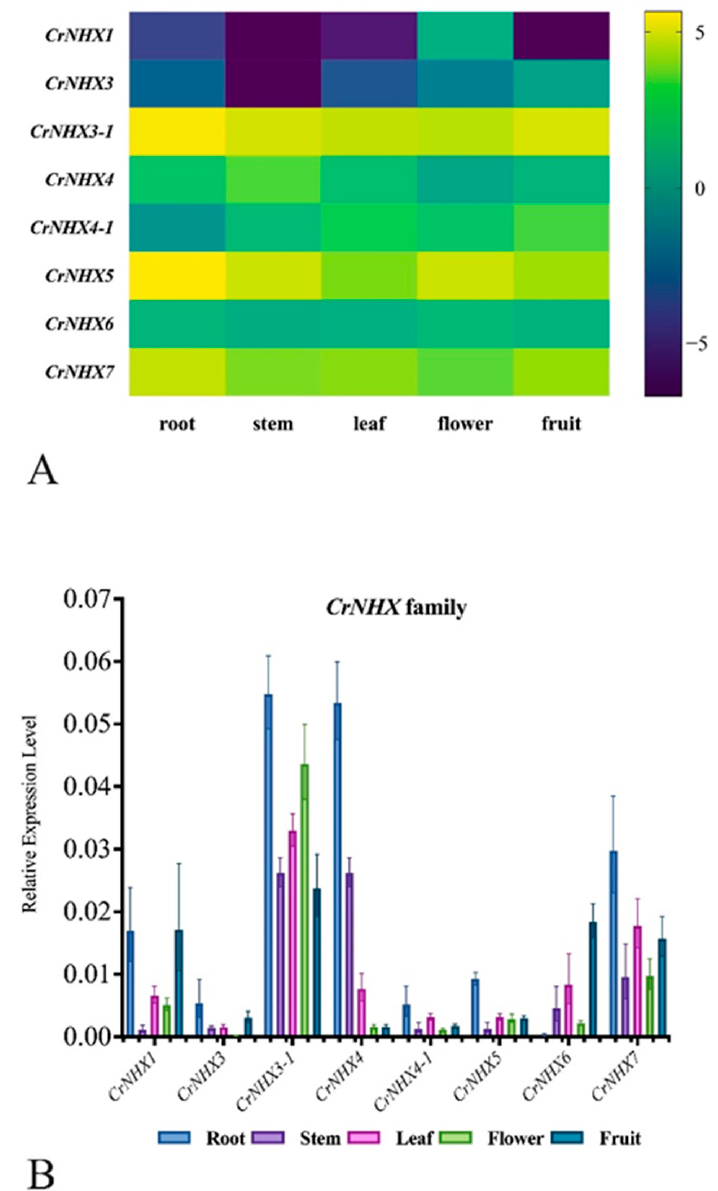
Figure 5. ( A ) Heatmaps showing the expression levels of the eight CrNHXs in the root, stem, leaf, flower bud, and young fruit of C. rosea plants. Expression levels for each CrNHX were shown with the log2 values of FPKM. Yellow denotes high expression levels, and dark-blue denotes low expression levels. ( B ) Expression differences of the eight CrNHXs confirmed by